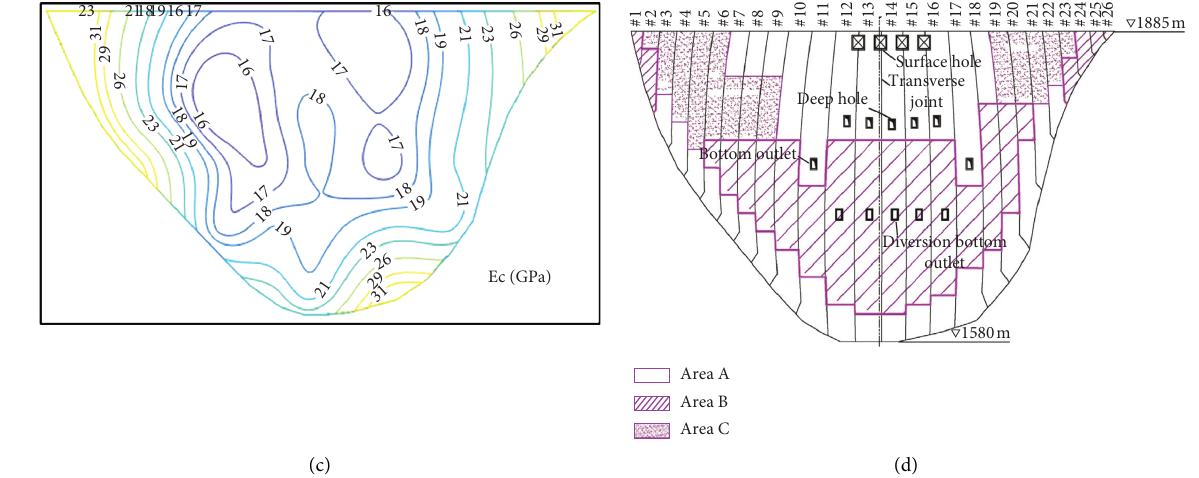
Figure 13: The maps of (a) field distribution of actual elastic modulus E 2014, and (d) zoning designation of concrete material